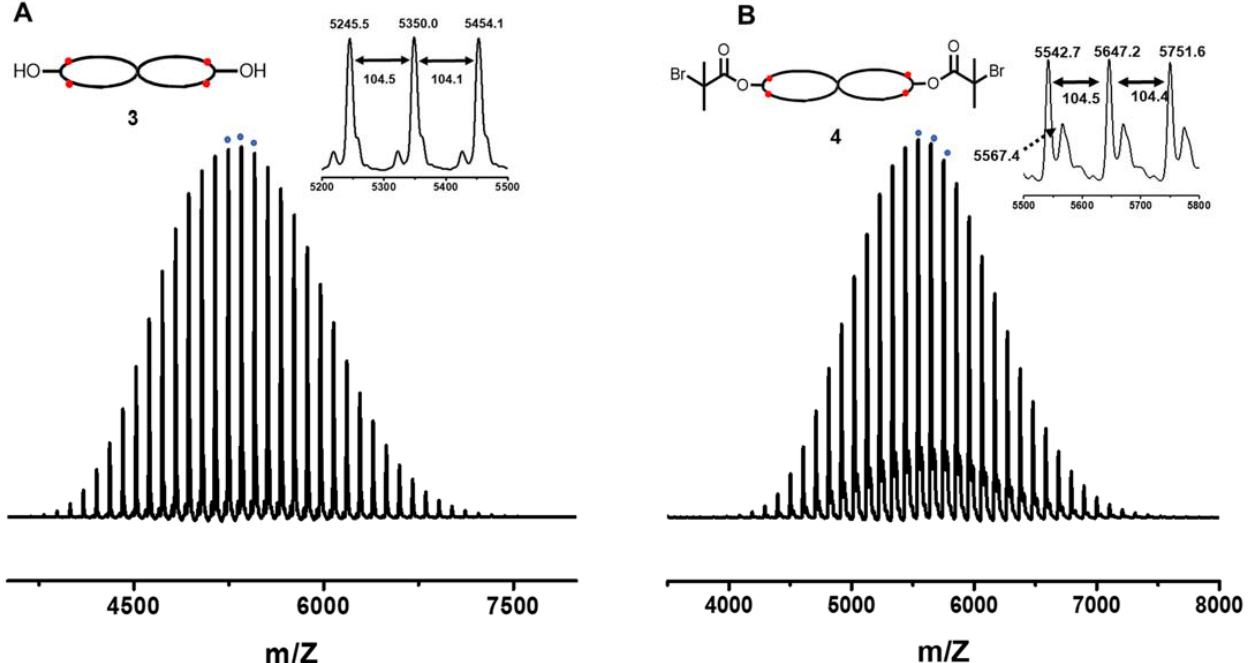
Figure 5. MALDI-TOF mass spectrum recorded using trans -2-(3-(4- tert -butylphenyl)-2-methyl-2-propenylidene) malononitrile (DCTB) and sodium trifluoroacetate as a matrix and cationization agent, respectively, for ( A ) spirocyclic PS and ( B ) the spirocyclic macroinitiator.